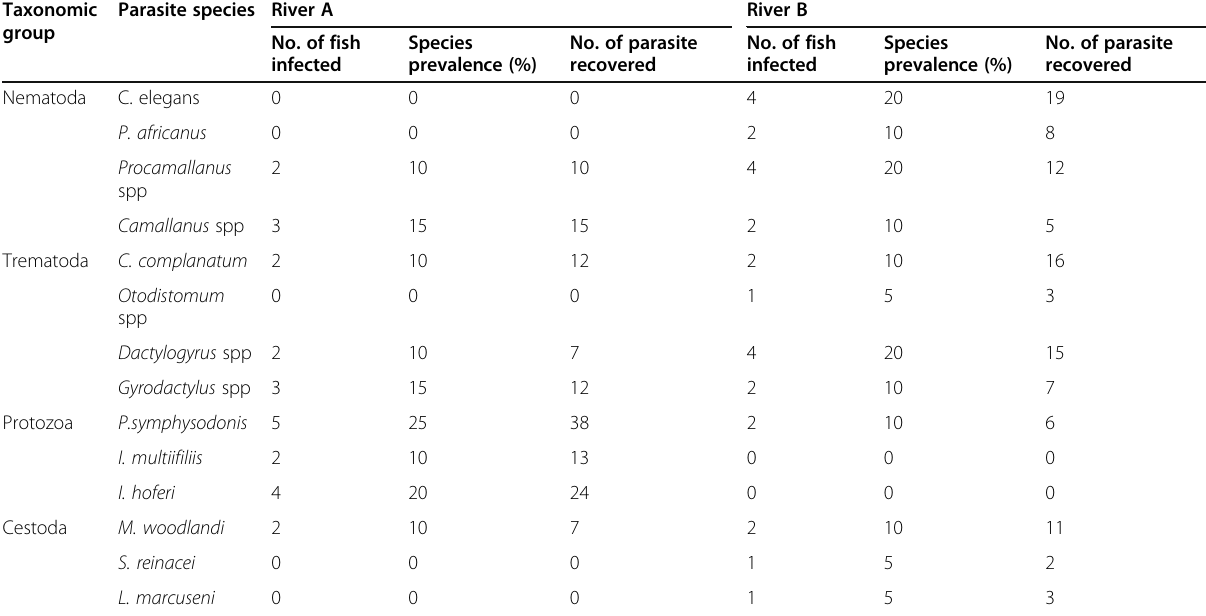
Otodistomum spp. was absent in the fish stomach (Table